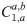
Disagreement between MCC and Kappa for C1,aa,b with a = 0.2, as function of b ≥ 0.If b > 1, the negative class is underrepresented and quite misclassified, and the positive class is mainly misclassified. (a) A zoom of the detail for b ≤ 2. (b) For b ≤ 30.